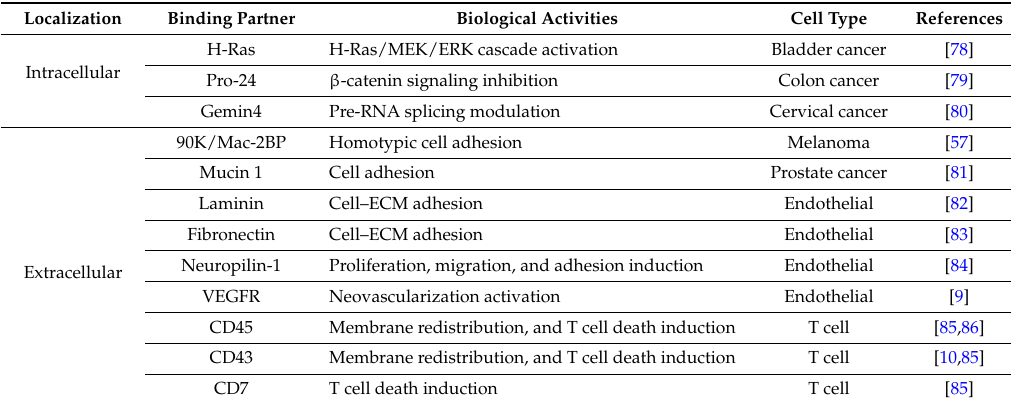
Table 1. Galectin-1 binding partners and associated cancer